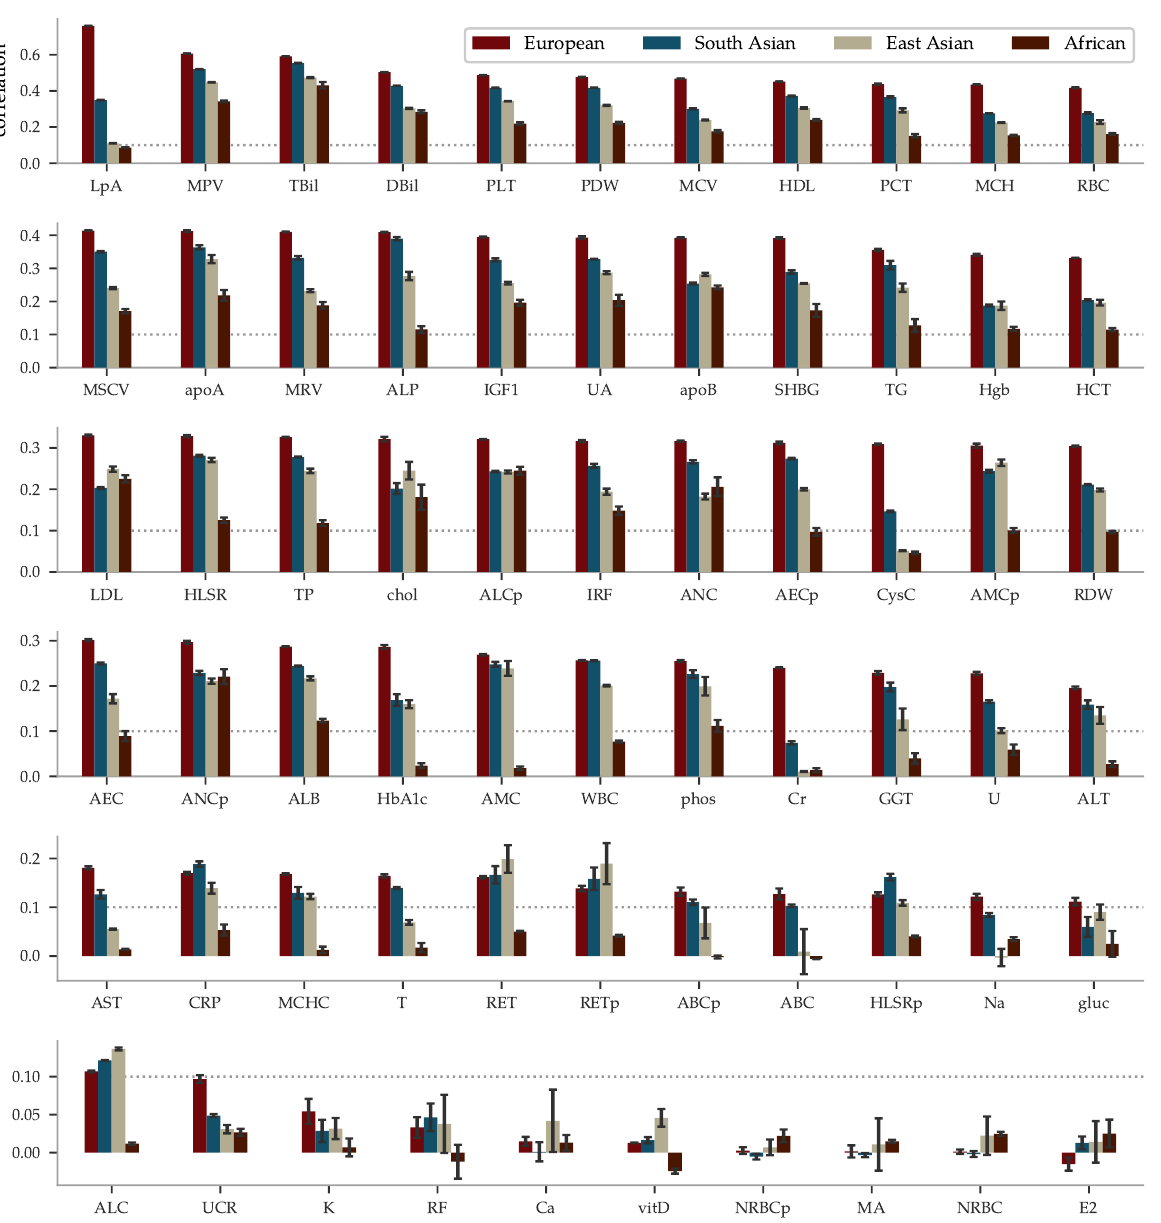
Figure 3. Correlations between PGS and phenotype vary from very strong to effectively zero, depending on the biomarker, and fall off with genetic distance from the training population. The mean of the PGS-phenotype correlation for evaluation sets are listed for all 65 biomarkers, ordered according to the results within Europeans—the ancestry for the training population. The error bars represent ± the standard deviation for 5 different predictors trained on slightly different training sets. The dotted line is there to aid graphical comparisons across the rows. The LASSO predictor of lipoprotein A achieves a correlation of 0.759 within European ancestry, which is the highest correlation for a polygenic trait we are aware of. The correlation fall-off for the other ancestries generally follows the order European > South Asian > East Asian > African. Note that the sample sizes for these ancestries are much